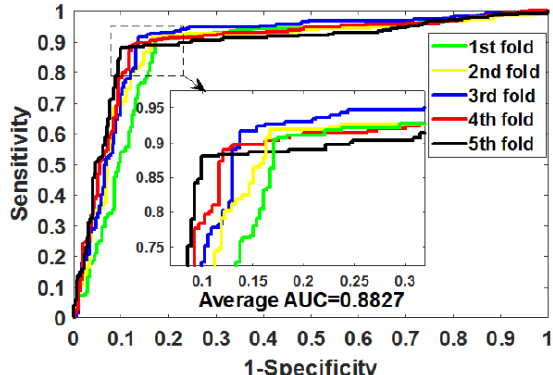
Figure 4. ROC curves of the 5FCV experiment acquired by RoFDT on the Ion Channel dataset.